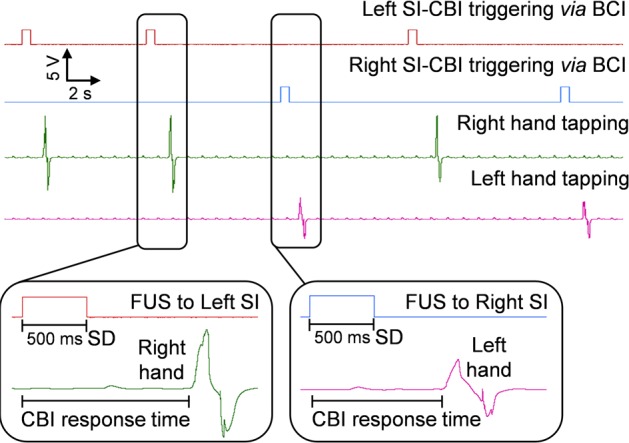
Exemplar view of CBI segment responses during a BBI session.FUS-mediated CBI segment exemplar capture screen of the BCI-originated trigger signals, which includes the elicited responses from the CBI segments.